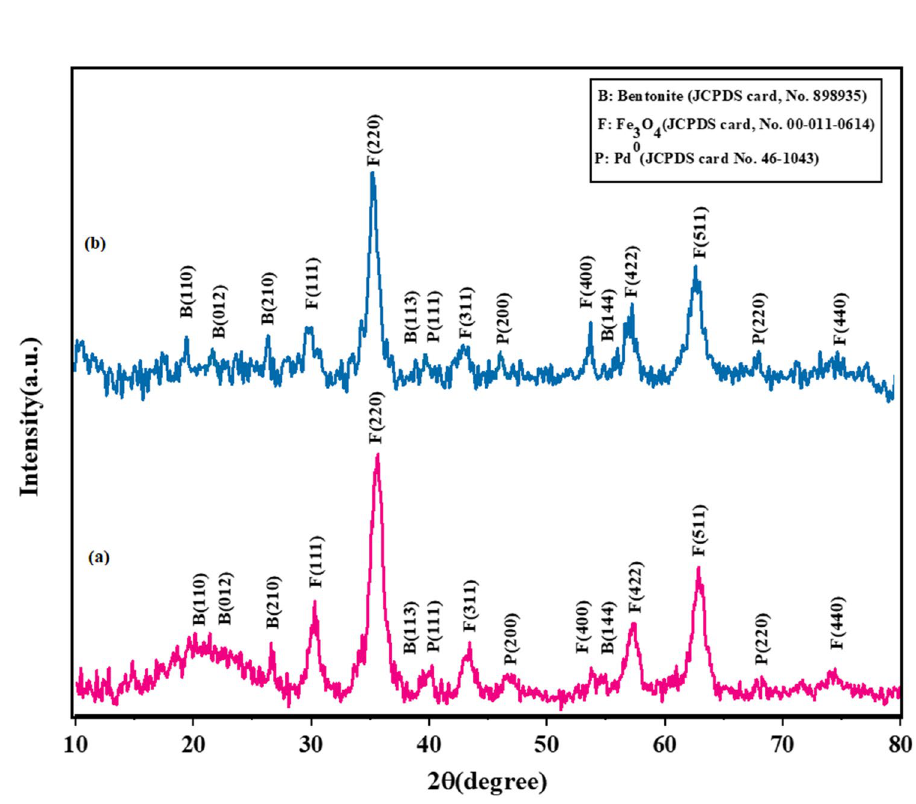
Figure 9. XRD pattern of ( a ) fresh, and ( b ) reused Fe-Ben/PVP-DVB/Pd